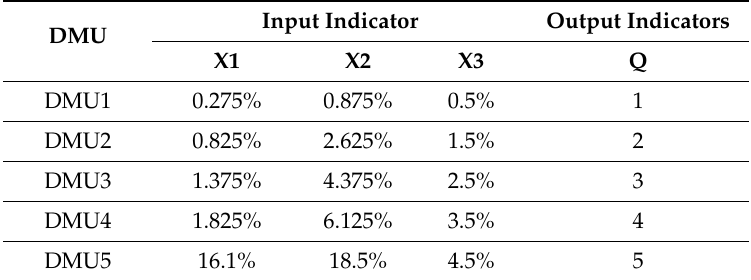
Table A2. Hierarchical decision-making units.